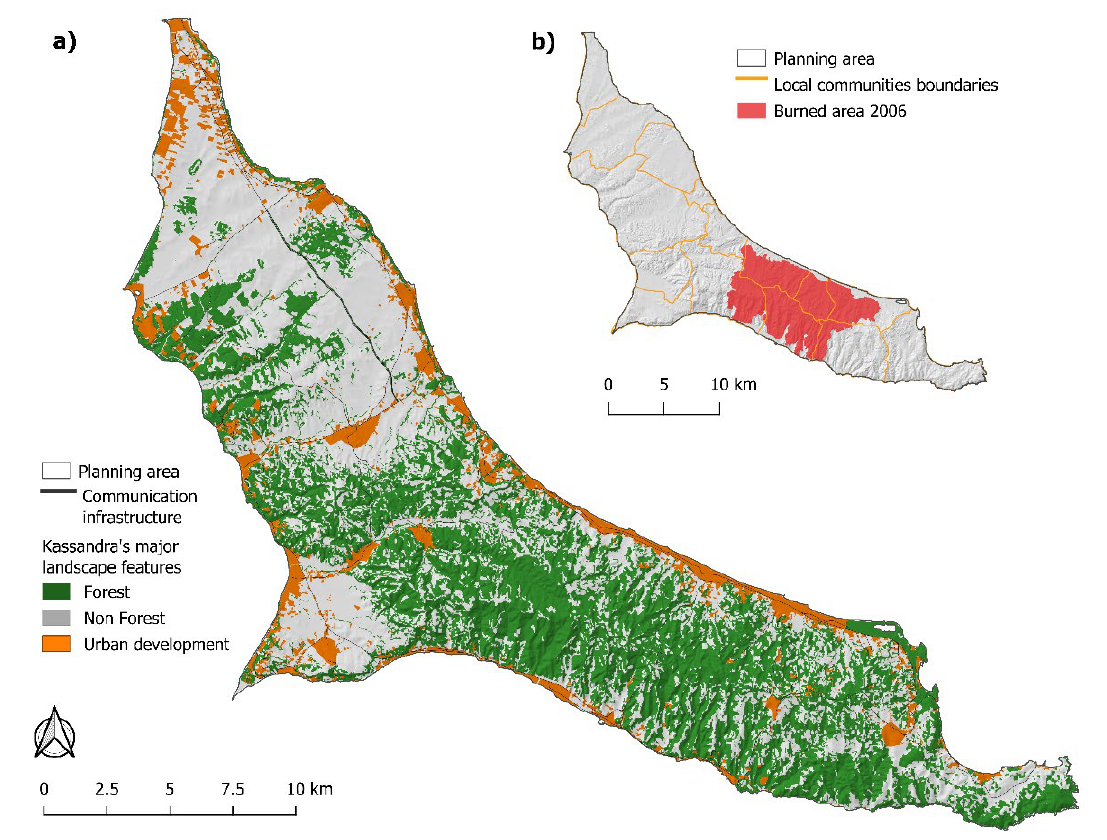
Figure 2. Study area ( a ) with major landscape features (forest, non-forest, urban development) and ( b ) the burned area of 2006.